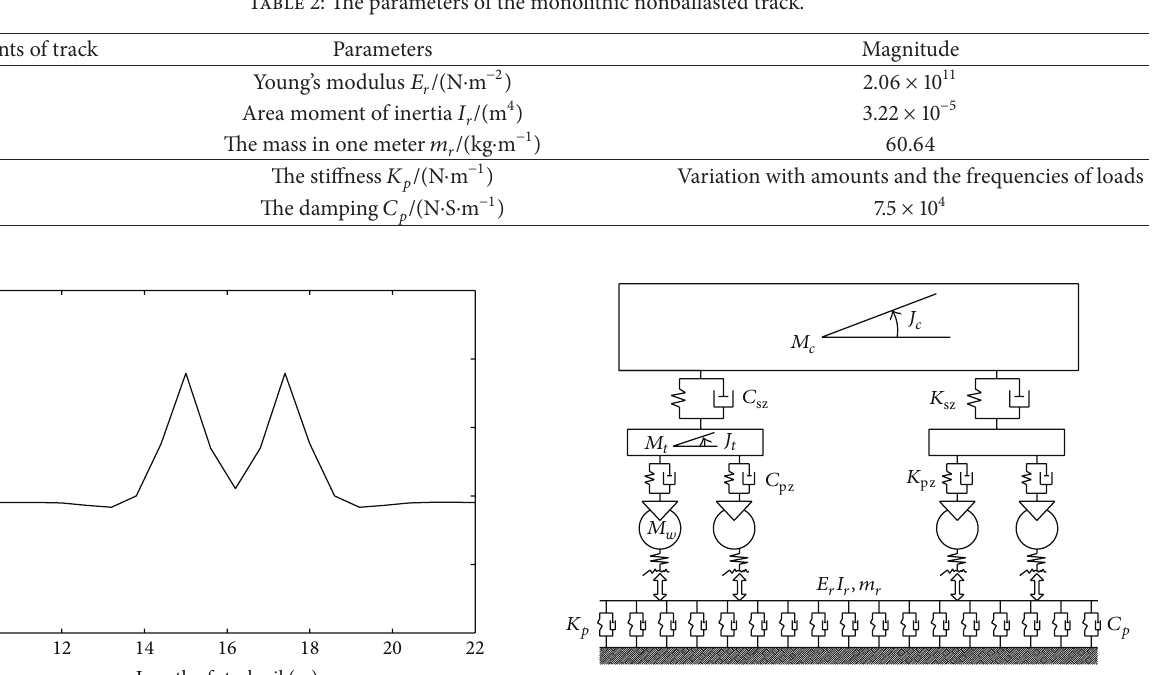
Figure 5: The static stiffness of TPE rail pads at different positions under a bogie.